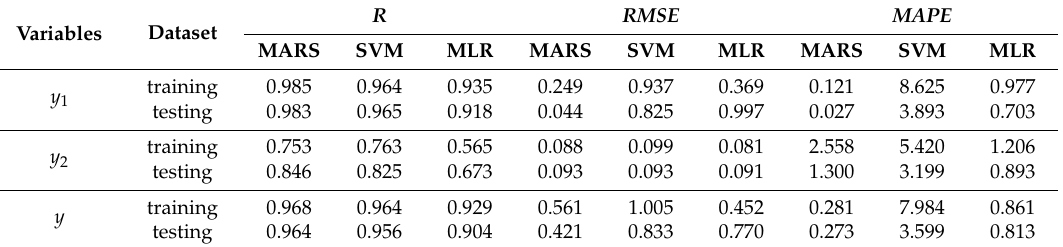
Table 7. Accuracy comparison among multivariate adaptive regression spline (MARS), support vector machine (SVM), and multiple linear regression (MLR) for the training and testing